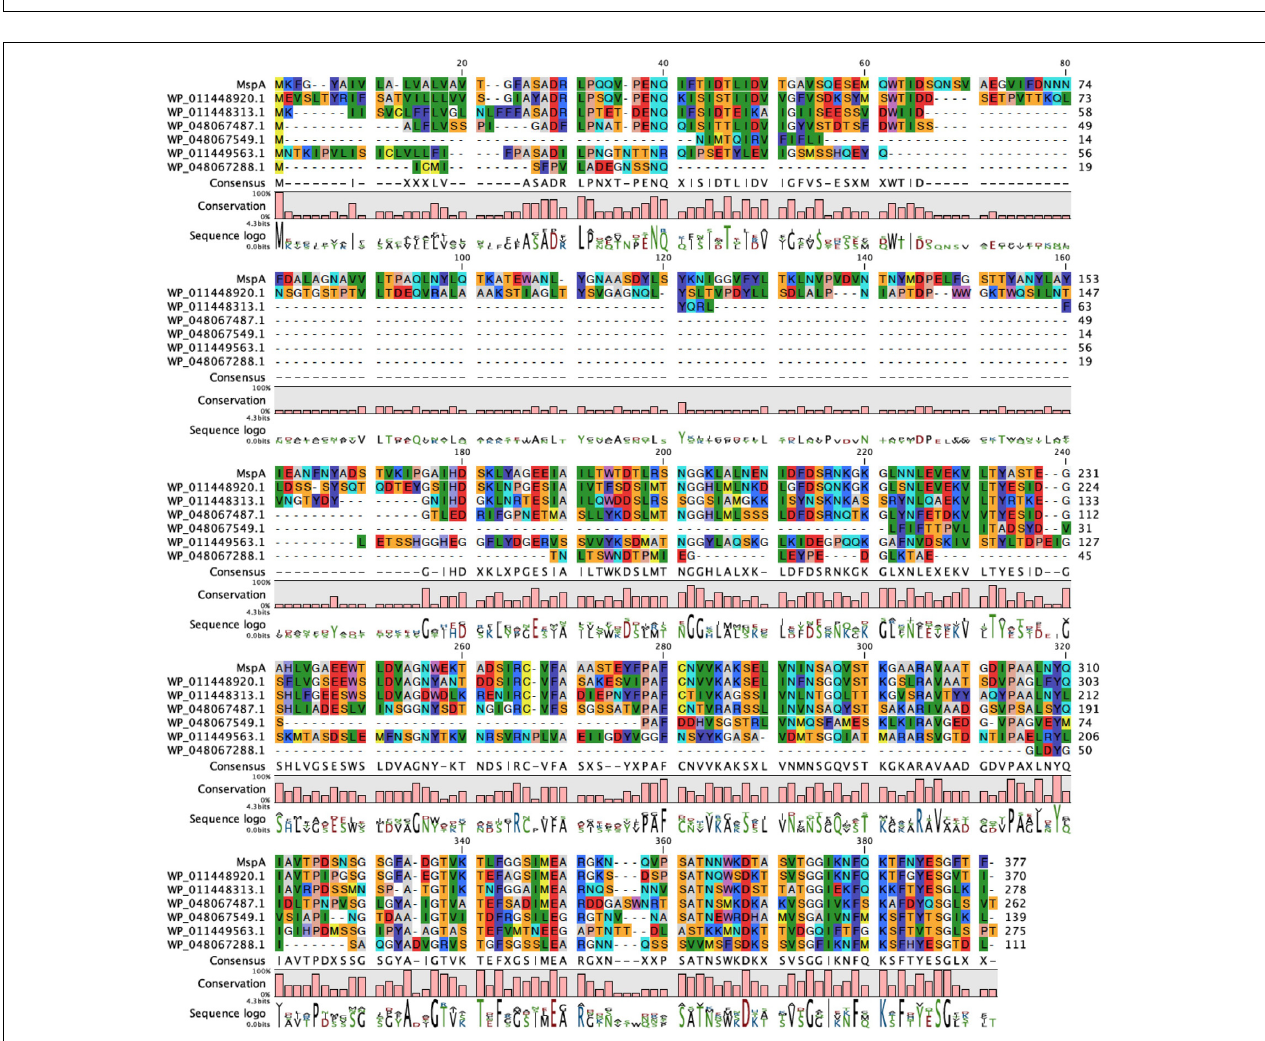
FIGURE 4 | Methanospirillum hungatei have six internal MspA homologs. Sequence alignment of MspA from M. hungatei JF-1 (WP_011449234.1) and its internal homologs. Residues are colored according to Rasmol standards.